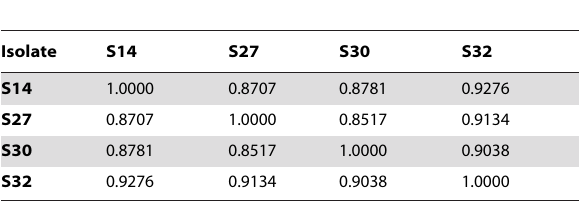
Table 4. In-house CCV analysis of MTB fingerprints of Pseudoalteromonas isolates from the North